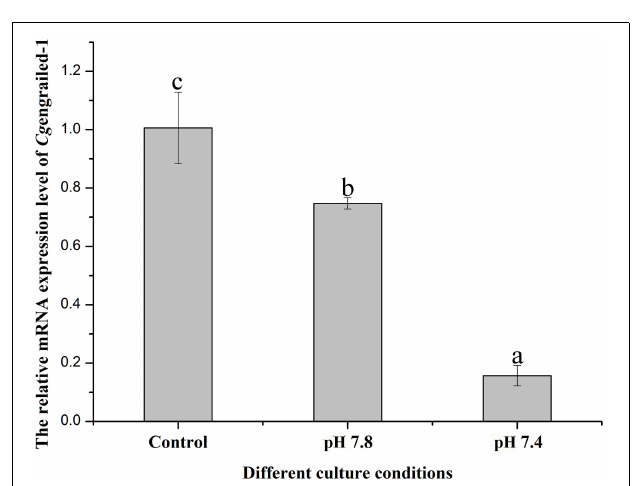
FIGURE 5 | Changes of Cg engrailed-1 expression in adult oyster mantle upon acidification treatment. The mRNA expression of Cg engrailed-1 in mantle tissue of adult oyster upon moderate (pH 7.8) and severe (pH 7.4) acidification treatments were determined by quantitative real-time PCR. Each value was shown as mean ± SD ( N = 3), and statistical significance ( p < 0.05) was marked by different letters